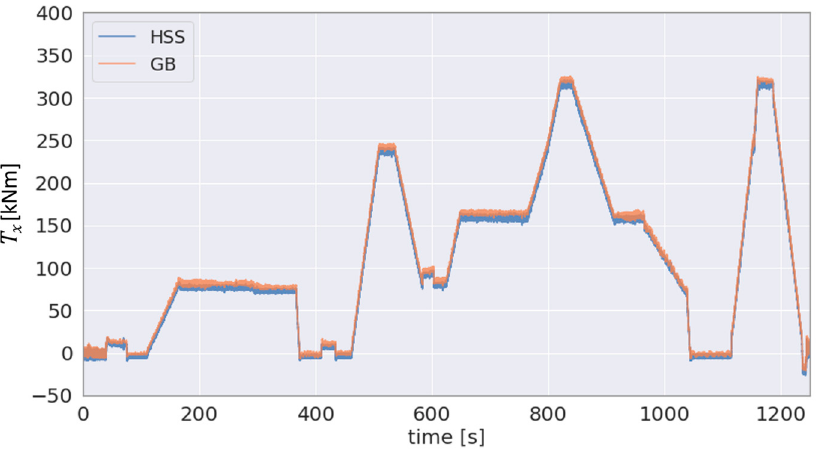
Figure 10. Estimated GB input torque at and measured torque at HSS (scaled using GB ratio).